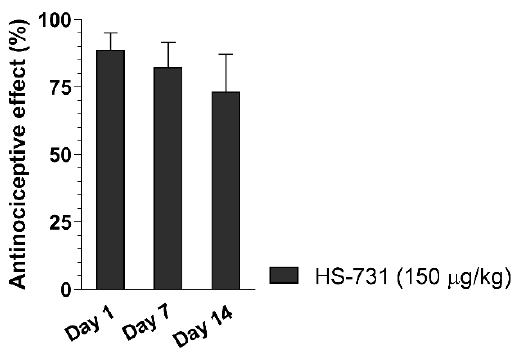
Figure 1. Effect of chronic treatment on the development of peripheral analgesic tolerance of HS-731 in the rat tail-flick test after systemic (s.c.) administration. Rats were s.c. administered daily for two weeks HS-731 (150 µg/kg). Antinociceptive effects were measured at days 1, 7, and 14, at 60 min after administration of HS-731. There was no significant effect day 7 vs. day 1 and day 14 vs. day 1. Statistical differences were determined with one-way ANOVA and Newman–Keuls multiple comparisons post-hoc test. Data represent means ± S.E.M (n = 7 per group). Experiments were